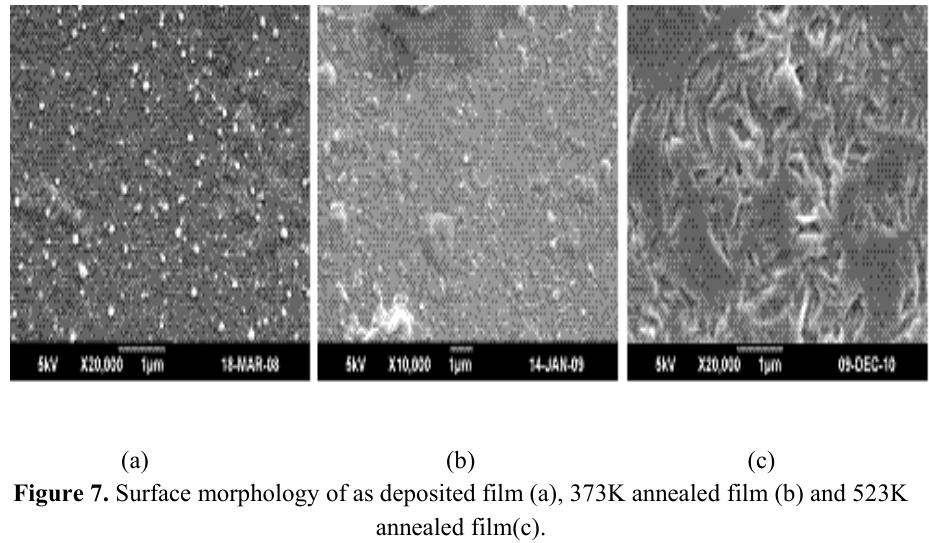
Figure 7. Surface morphology of as deposited film (a), 373K annealed film (b) and 523K annealed